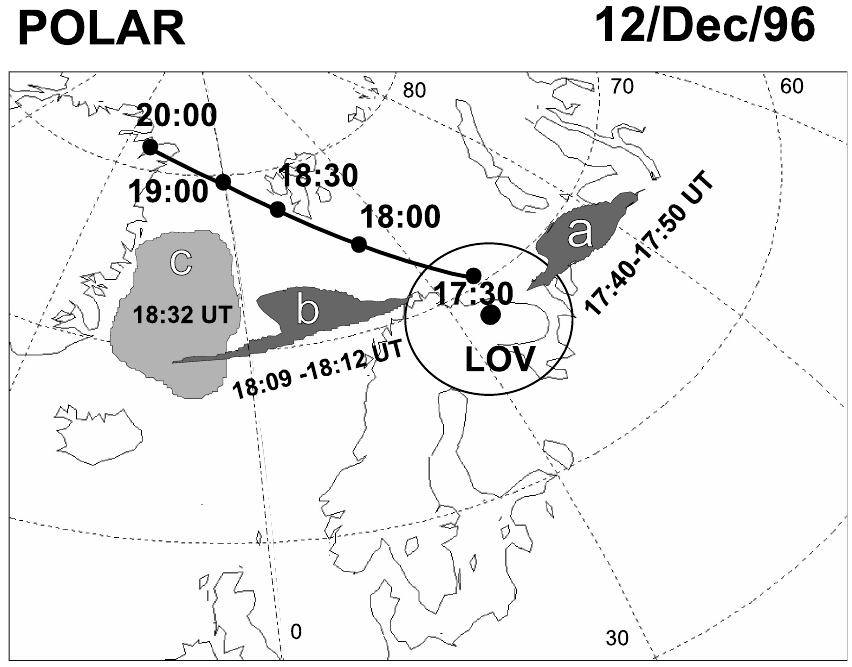
Fig. 6. The projection of the POLAR orbit on 15 December 1996 is shown by a line marked with time points. The dark areas “a”, “b”, “c” show schematically the position of aurora maximum for the different times. A circle is the field of view of the all-sky TV camera situated in